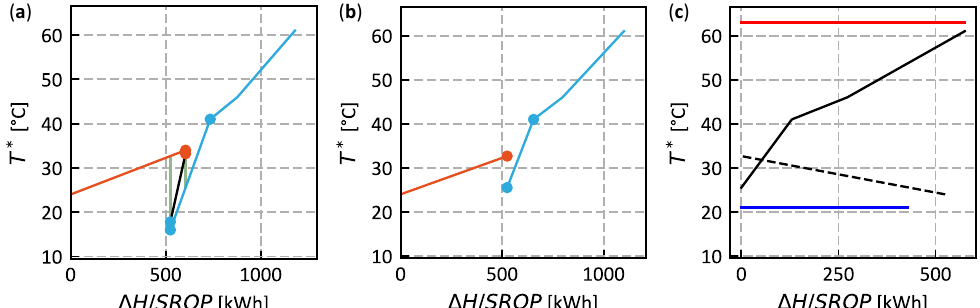
Figure 4. Design procedure of split IHR and HPTES system: ( a ) design of HESN for IHR solution; ( b ) residuals of ISSP after design of IHR solution; ( c ) inverted residual ISSP for HP placement with the residual heating demand (solid black line), residual cooling demand (dashed black line), and HP evaporator and condenser (solid blue and red line,